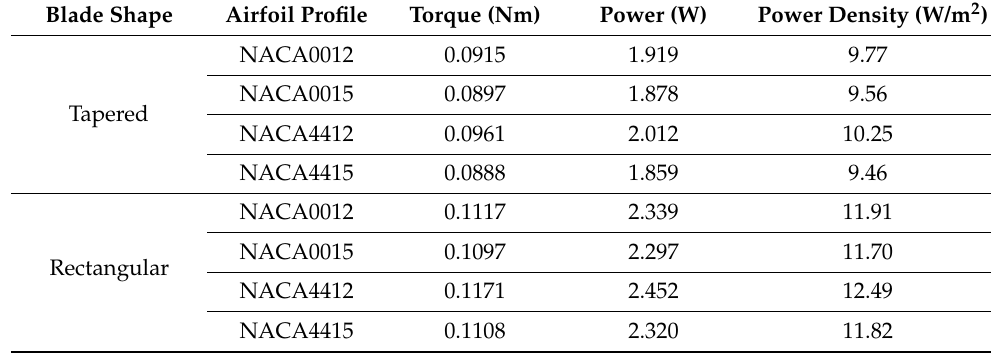
Table 7. Power generation for the studied blade shapes and corresponding airfoil